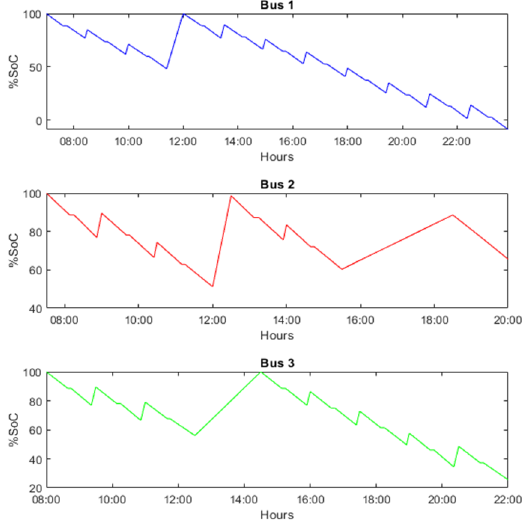
Figure 16. SOC of the three buses with one Opp Charger of 450 kW.